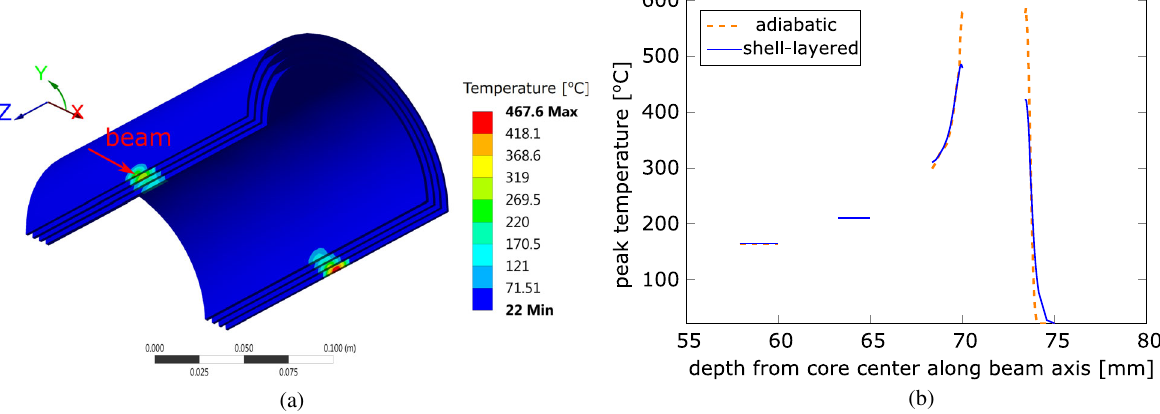
FIG. 5. (a) Thermal distribution in a beam stopper made of four concentric cylindrical shells out of graphite. The XZ plane is used for symmetry. (b) Peak temperature in the last four shells hit by the beam along the beam axis using a layered-shell model.